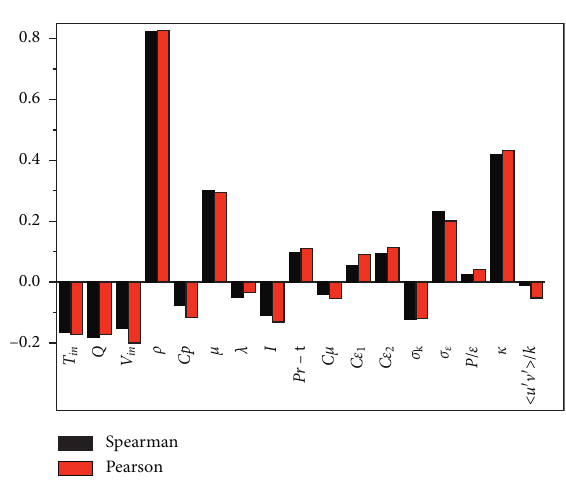
Figure 4: Correlation coefficients of C